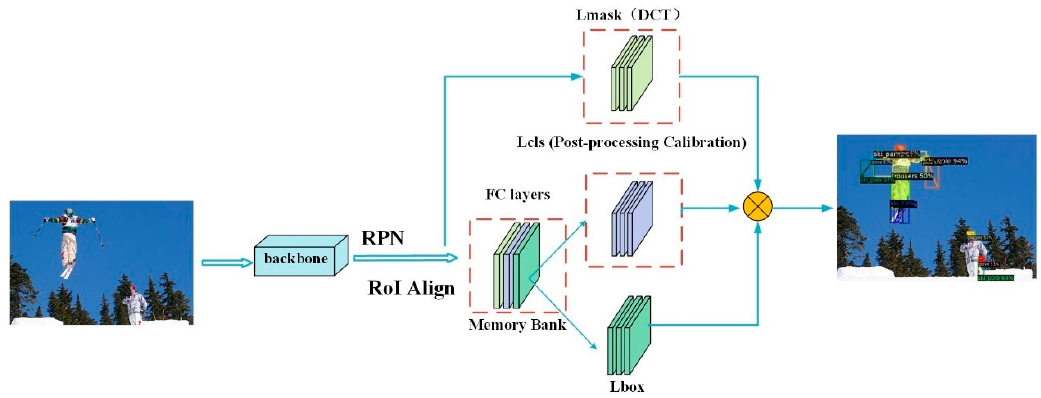
Figure 1. Framework of the proposed